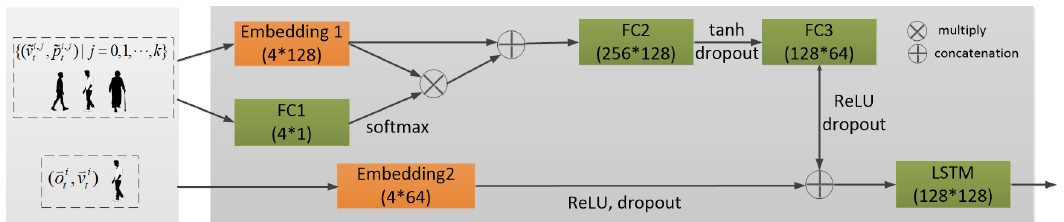
Figure 6. Subnetwork modeling human interaction with relative motion. FC is a fully connected layer with activation function ReLU. The first number inside the bracket is the input size of this layer and the last number is the output size. Through this subnetwork, a social tensor representing the agent–neighbor interaction can be